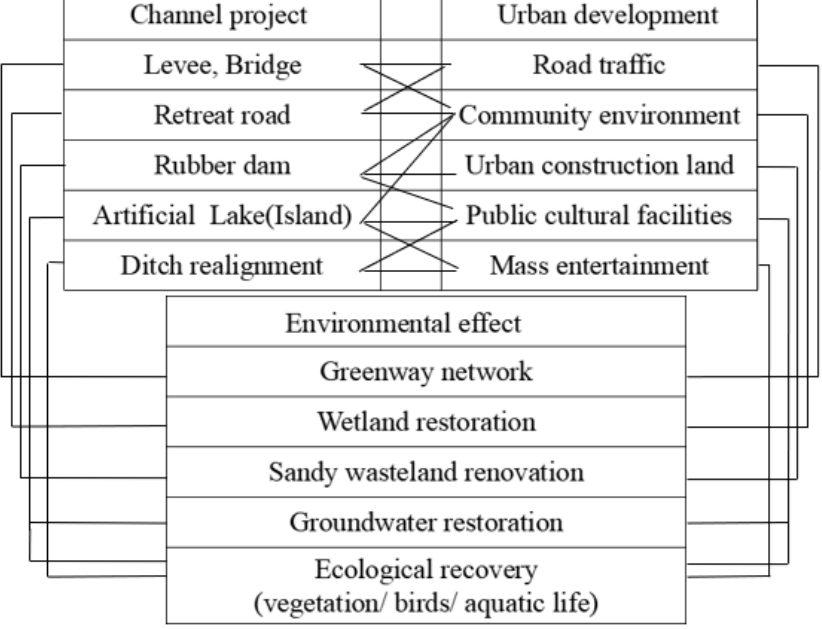
Figure 18. The inter-relationships among the city, river and ecological environment addressed in Luanhe River regulation projects.